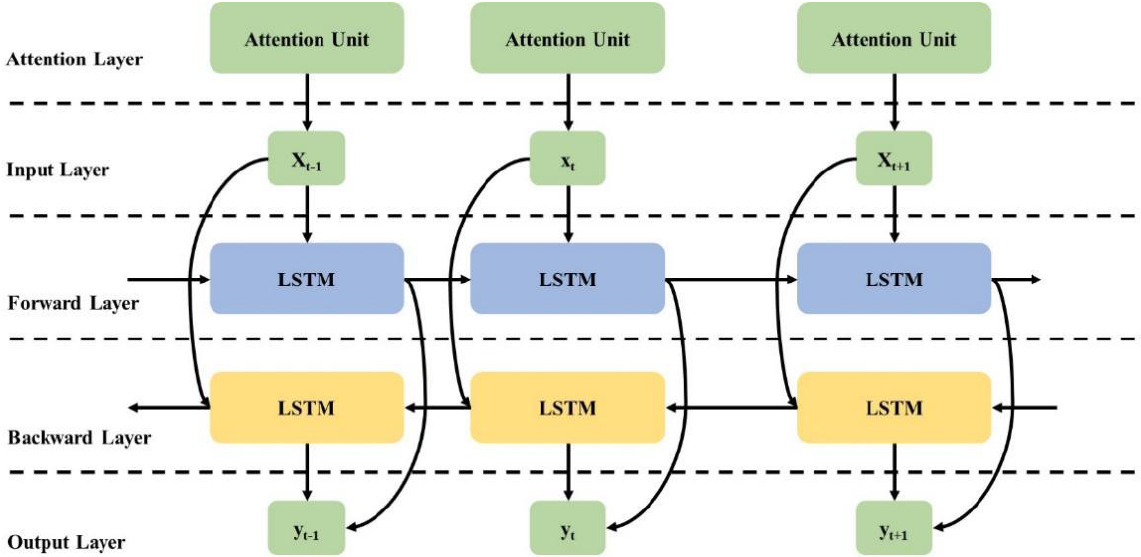
Figure 5. Attention unit with BiLSTM model for classification.